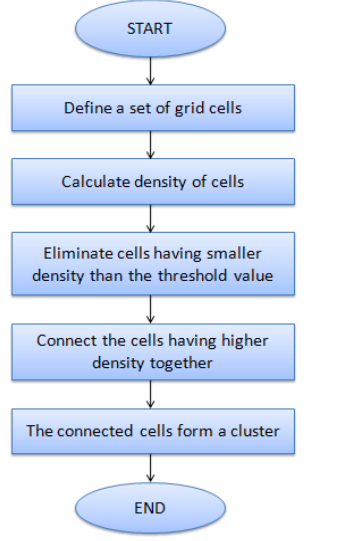
Fig. 17. Grid-based